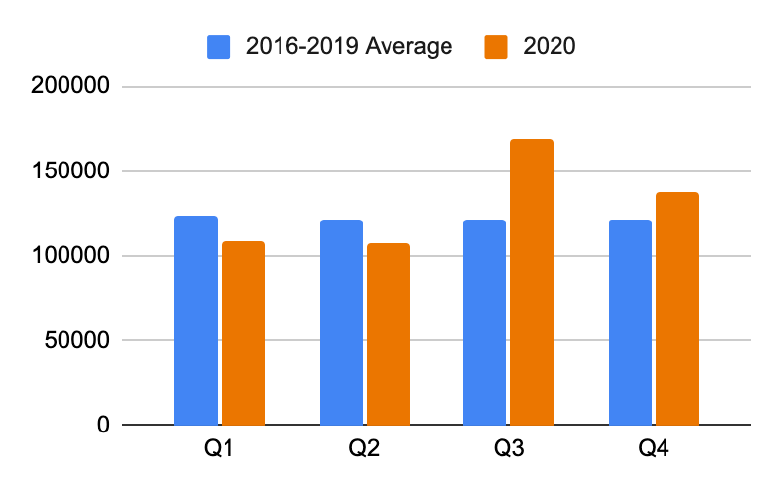
Figure 1: Applications for new businesses with planned wages, 2016 - 2019 average and 2020 (US Census Bureau 2020)